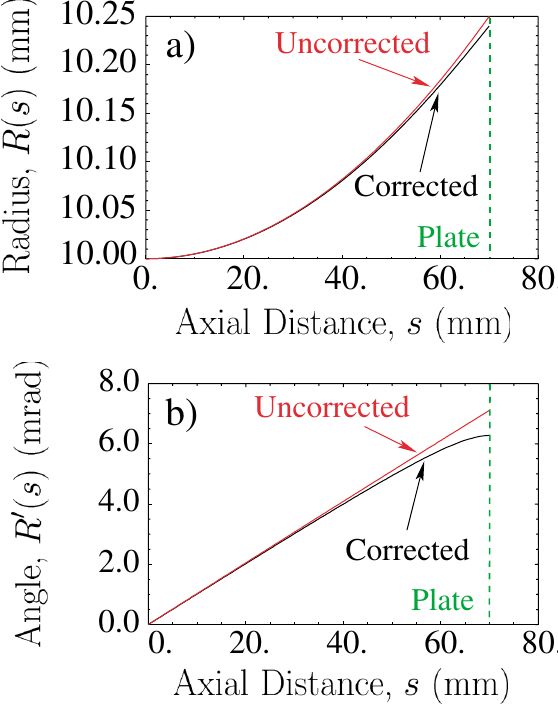
FIG. 6. (Color) Evolution of (a) envelope radius R and (b) angle R 0 given by Eq. (20) for an axisymmetric beam free drift expanding into a conducting plate. Solutions are (cid:3)j s (cid:2) s j =R (cid:4) ] and uncorrected given for corrected [black, F a p (cid:1) 1 ] evolutions. Beam parameters are Q (cid:1) 10 (cid:19) 10 (cid:2) 4 [red, F a (cid:1) and " (cid:1) 50 mm mrad , the conducting plate is at s (cid:1) s p 70 mm , and initial conditions at s (cid:1) 0 are R (cid:3) 0 (cid:4) (cid:1) 10 mm and R 0 (cid:3) 0 (cid:4) (cid:1) 0 .